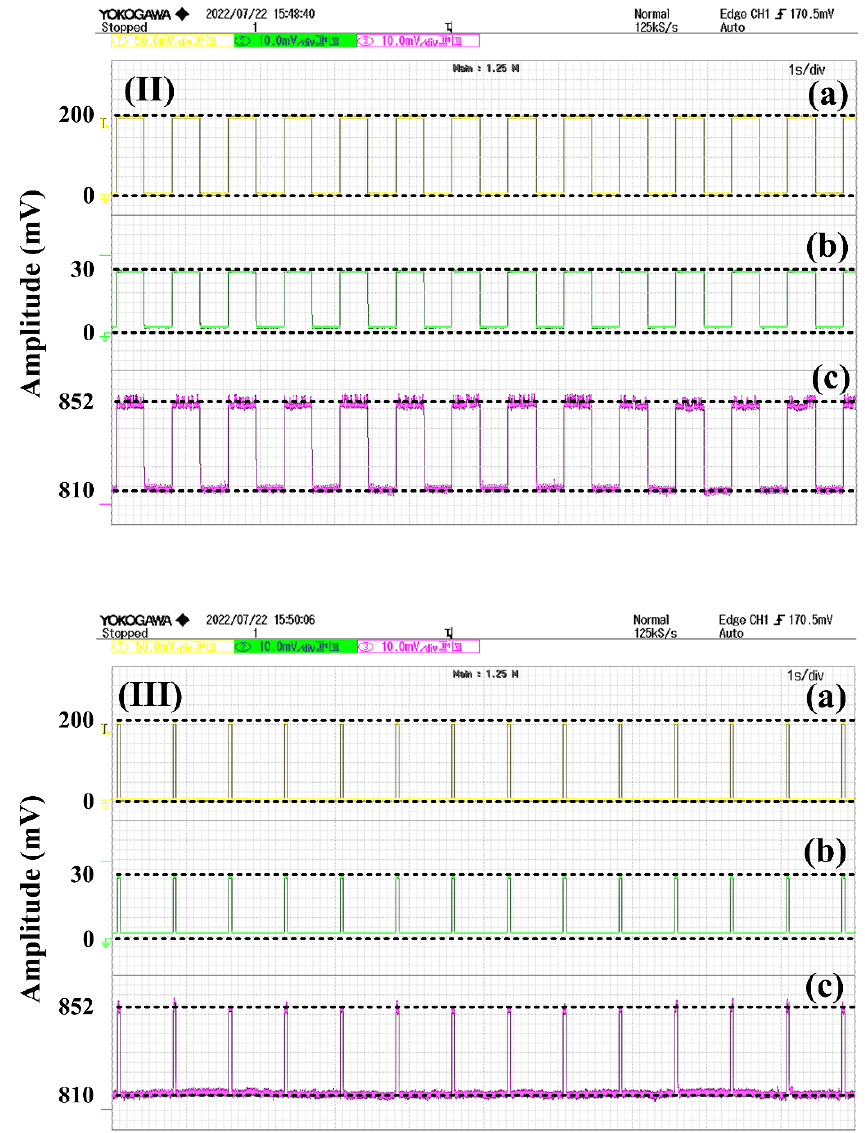
Figure 9. Time-domain characterization of the optoelectronic sensing SoC by using different electri- cal/optical modulating waveforms: panel ( I ) a sinusoidal waveform; panel ( II ) a square waveform; panel ( III ) a periodic sequence of pulses. In all the panels, the digital oscilloscope trace ( a ) is the AWG electrical signal used to modulate the laser beam power, trace ( b ) the optical replica of the trace ( a ) detected by PD2 (see Figure 7); and trace ( c ) is the resulting SoC output voltage V OUT .